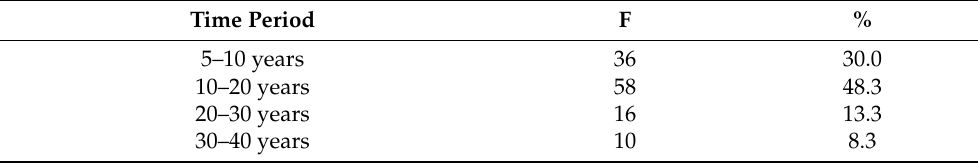
Table 8. Time frame for the development of an alternative diversification model.